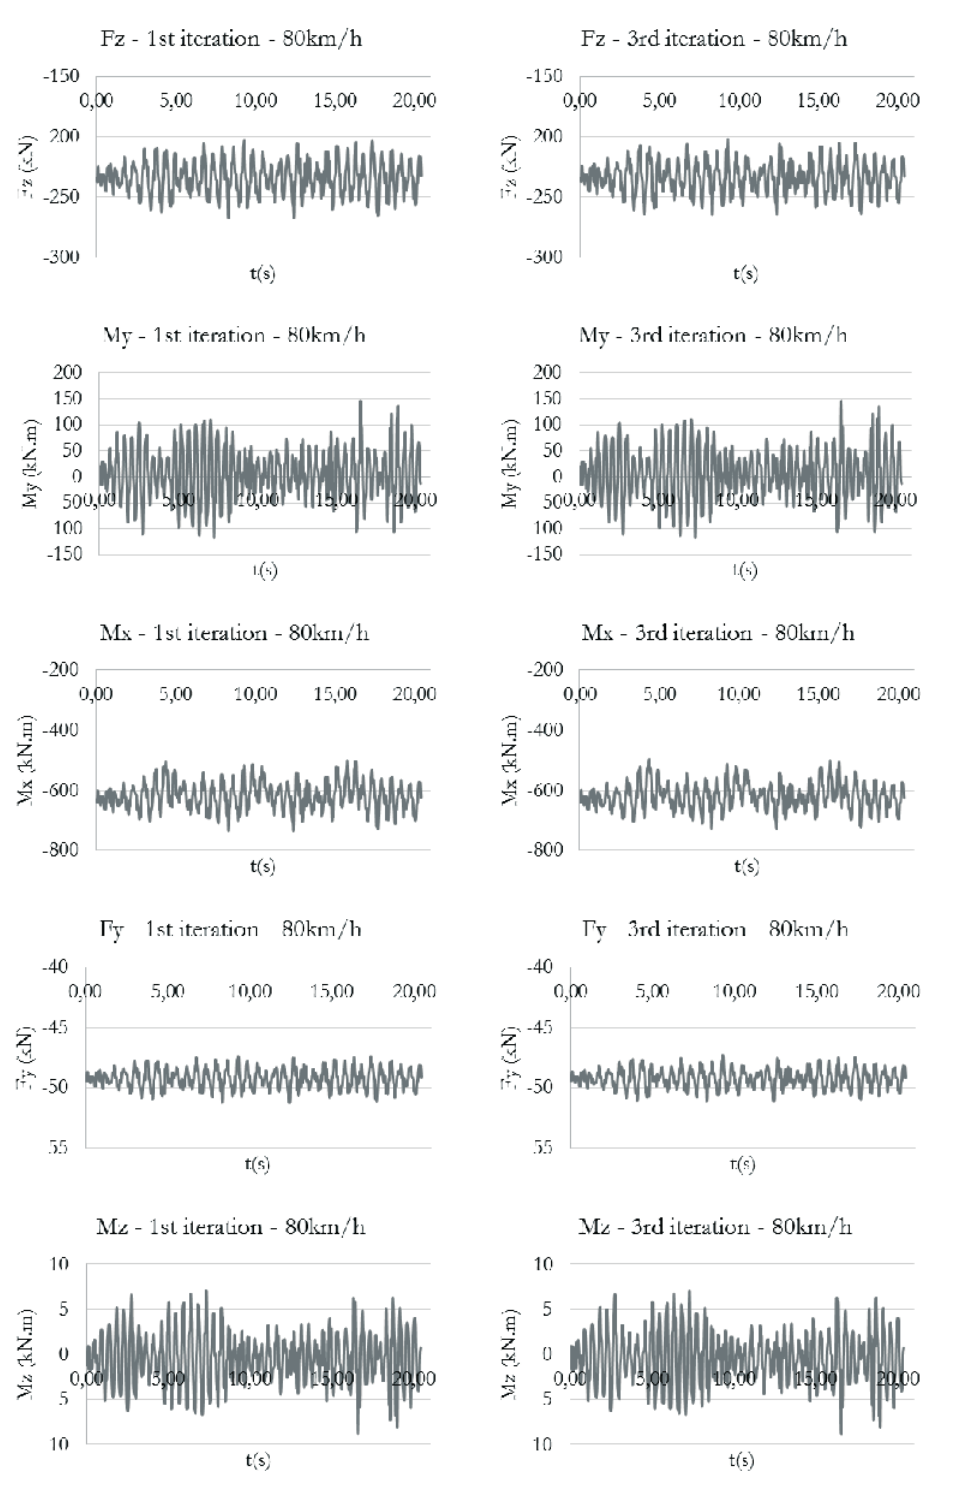
Comparison of the efforts applied to the bridge in the 1st iteration (rigid deck) and 3rd iteration with velocity of 80